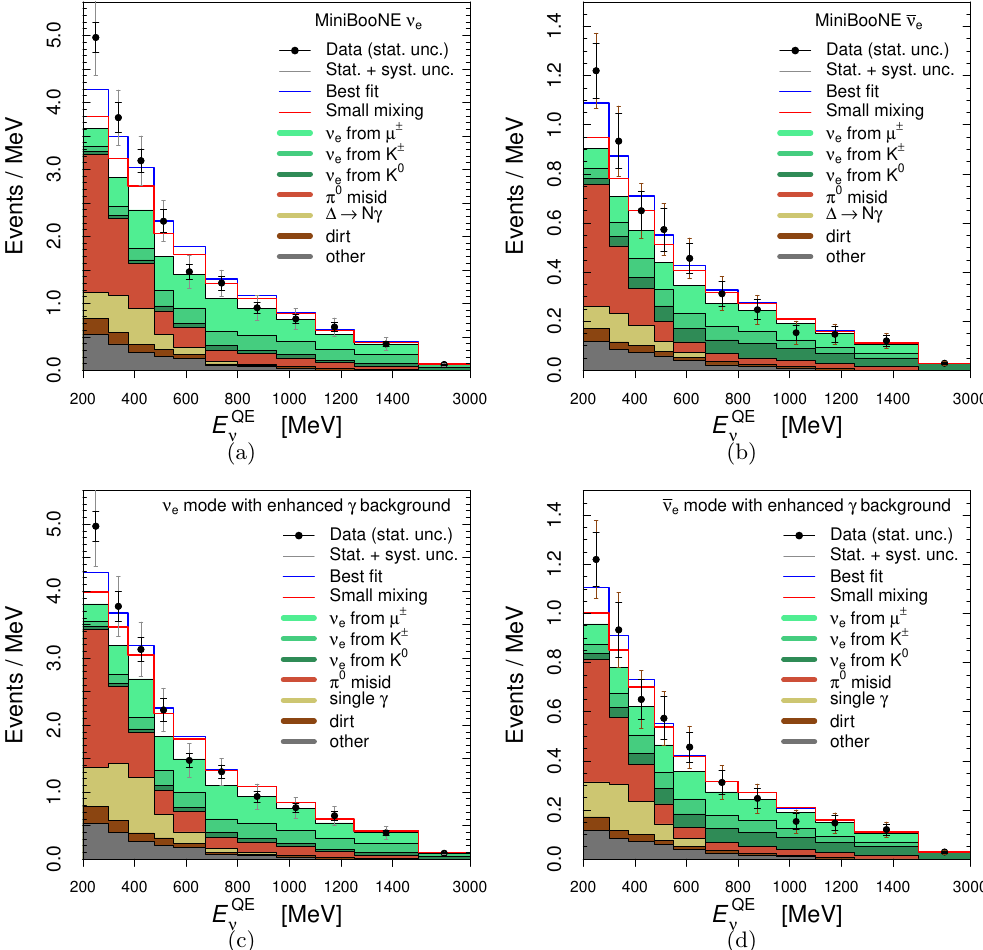
Figure 1 . Comparison of a reproduction of the MiniBooNE event histograms in (a) neutrino and (b) antineutrino mode from refs. [2, 25] with our versions (c) and (d) obtained with the enhanced single- γ background due to A 1 / 3 π 0 FSI in 12 C, coherent photon emission, incoherent production of higher mass resonances, and incoherent non-resonant nucleon production. The blue and red lines show, respectively, the expectations for neutrino oscillations corresponding to the best fit in table 2 (almost maximal mixing) and the case of small mixing with sin 2 2 ϑ eµ = 2 . 5 × 10 − 3 and ∆ m 2 = 0 . 8 eV 2 41